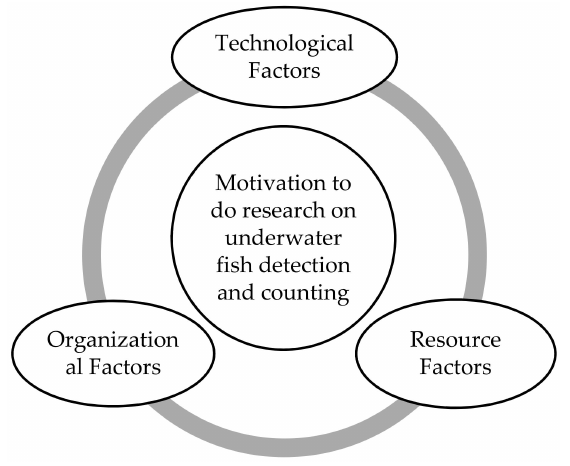
Figure 2. Conceptual diagram of this